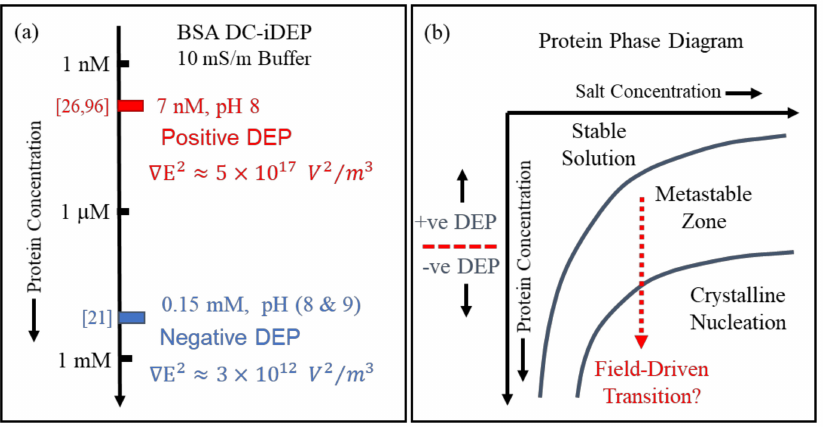
Figure 11. ( a ) BSA samples at the same buffer conductivity and pH exhibit negative iDEP at a concentration of 0.15 mM [21], but positive iDEP at 7 nM [26,98]. The low magnitude of ∇ E 2 m associated with the negative DEP result suggests minimal influence of a non-linear electrokinetic or electrothermal effect. ( b ) A simple protein phase diagram [99,100] to show how crystallization might occur during the DEP of a protein sample in a metastable